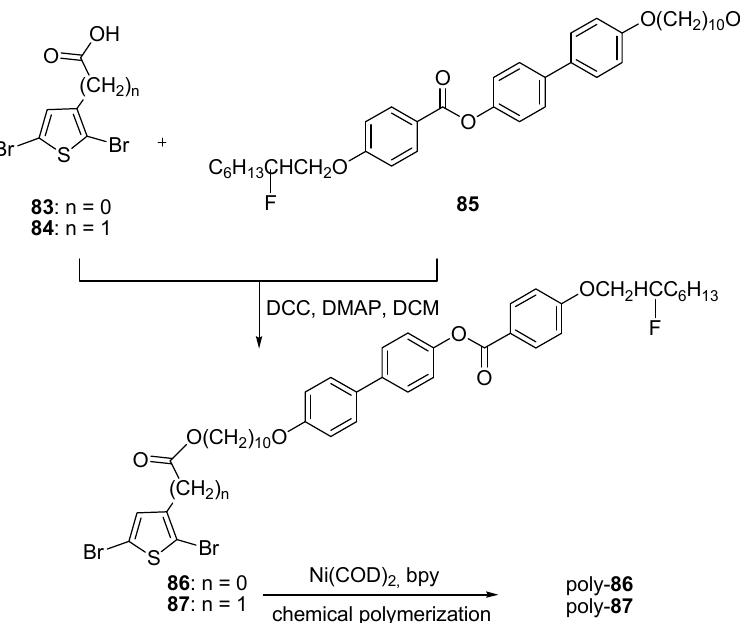
bromothiophene 63